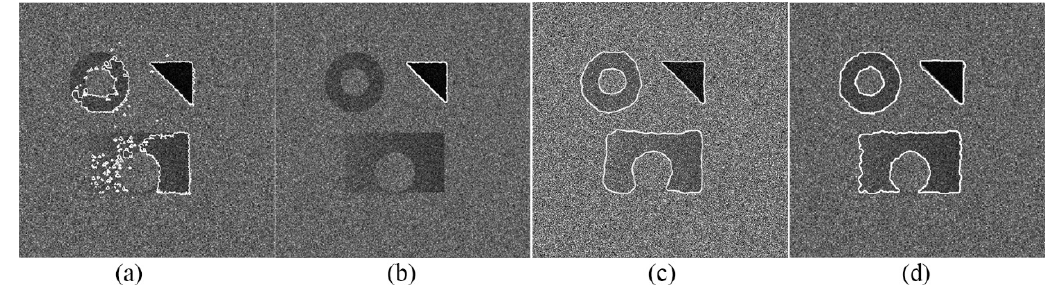
Figure 7. Comparison of segmentation results with different methods. ( a – d ) Results from METHOD1, METHOD2, METHOD3 and our method, respectively. Table 1. DoS (difficulty of segmentation) and CRF (cross ‐ region fitting) for the simulated SAR image in Figure 7.